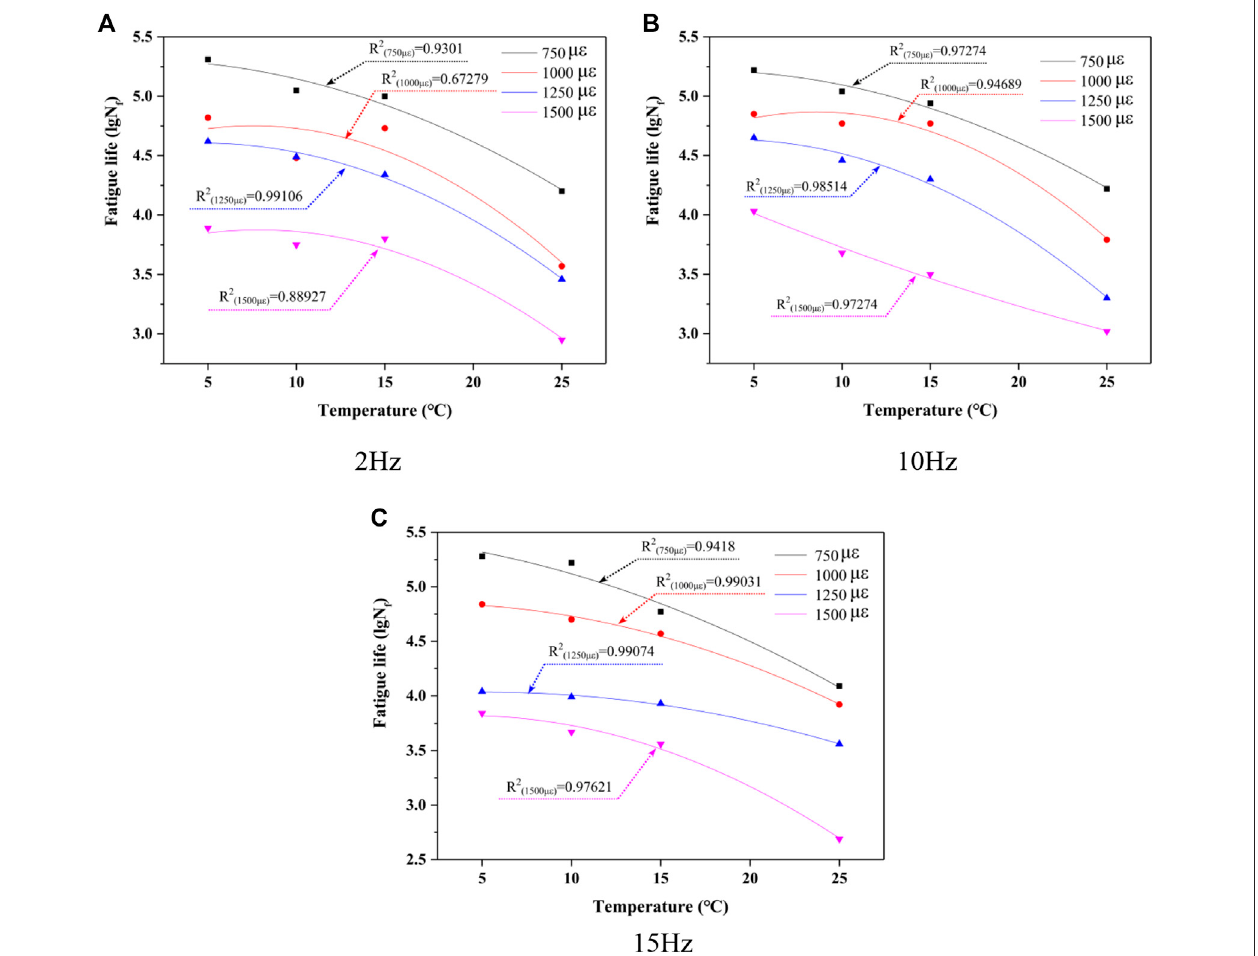
FIGURE 7 | Effect of temperature on the fatigue life: (A) 2 Hz; (B) 10 Hz; (C) 15 Hz.